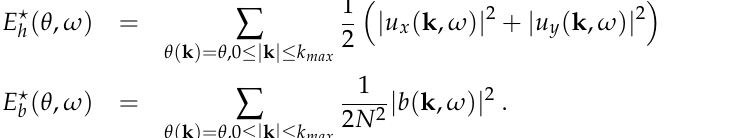
Figure 12 (Column 1)—for the complete horizontal, vertical and buoyancy energies E (cid:63) E (cid:63) —shows that, after the spatiotemporal decomposition, the energy is concentrated on the dispersion b relation curve of the waves, as well as away from the dispersion relation, for high angle θ and for a